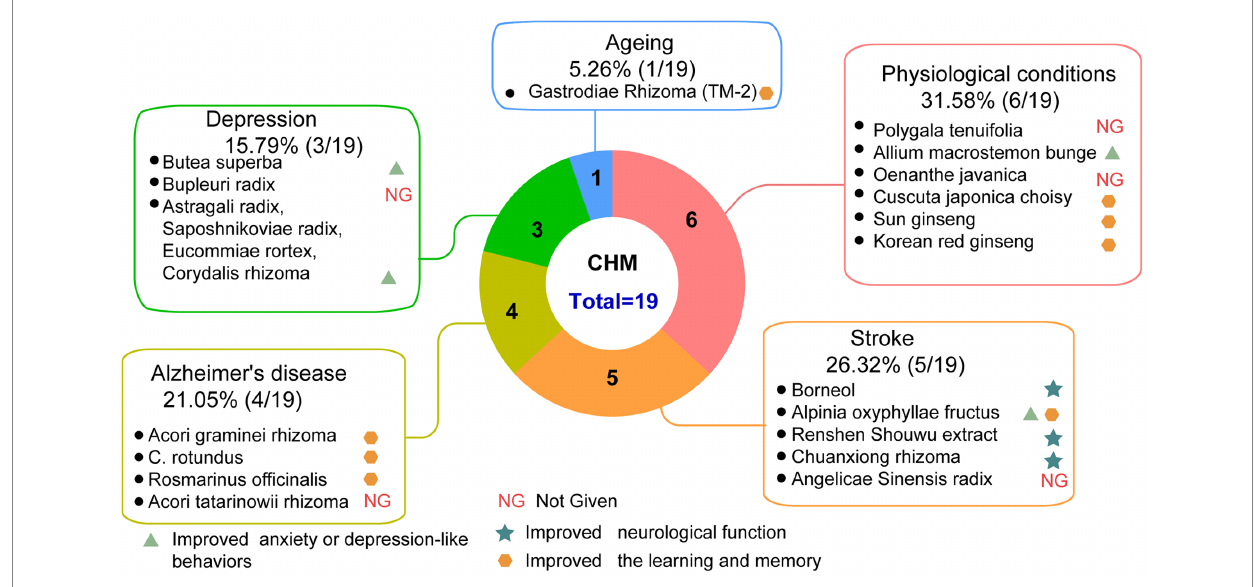
FIGURE 3 The effect of Chinese herbal medicine on adult neurogenesis and brain function, n =